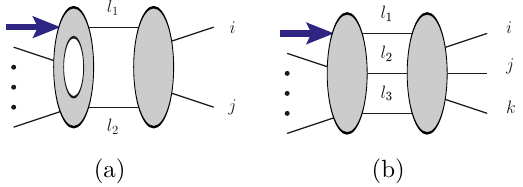
Figure 6. Unitarity cuts which are same for two-loop minimal form factors in gauge